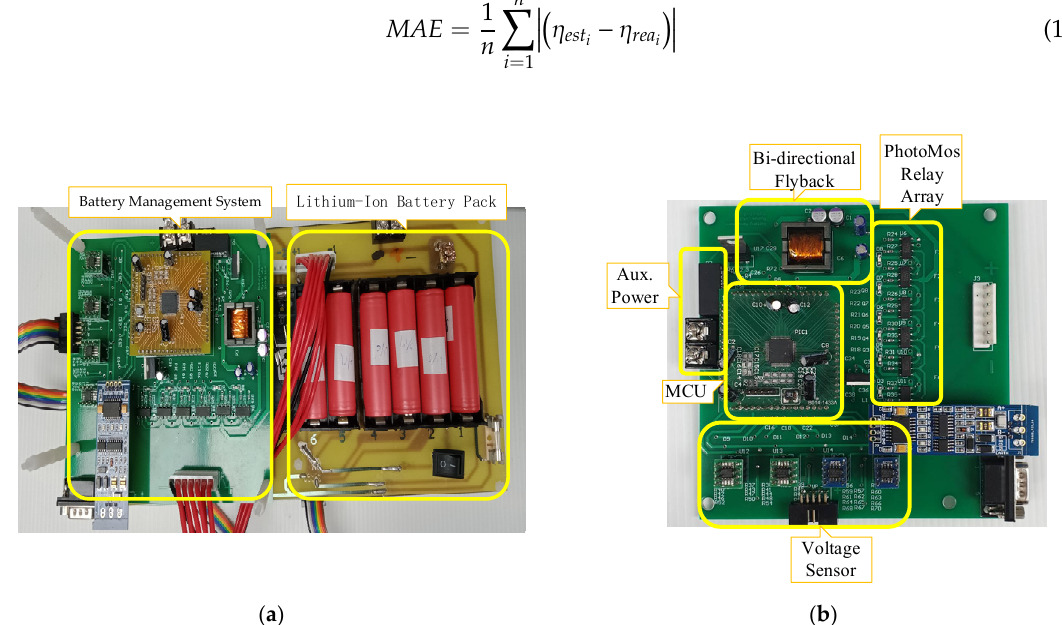
Figure 8. Photos of the proposed cell balancing system based on a bidirectional flyback converter ( a ) laboratory setup ( b ) battery management system.